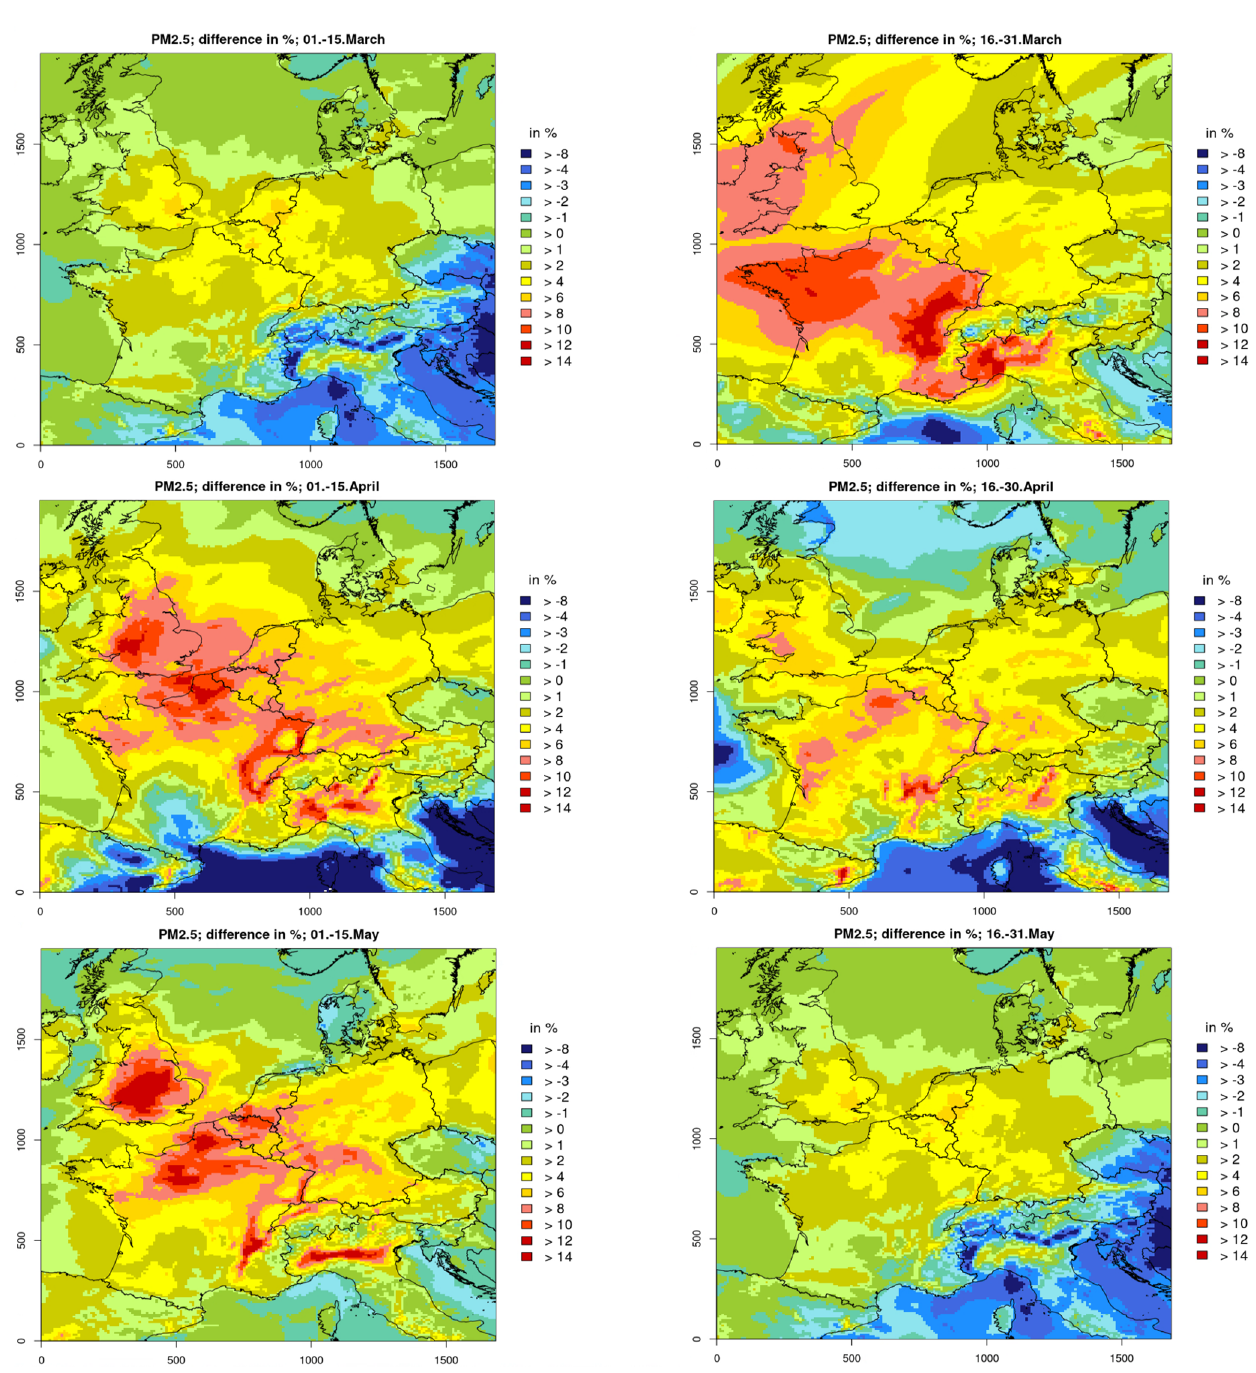
Figure A8. CMAQ results for relative PM 2 . 5 concentration reductions due to lockdown measures (noCOV – COV run) in central Europe between 1 March and 31 May 2020 in half-monthly intervals; positive values denote reductions.